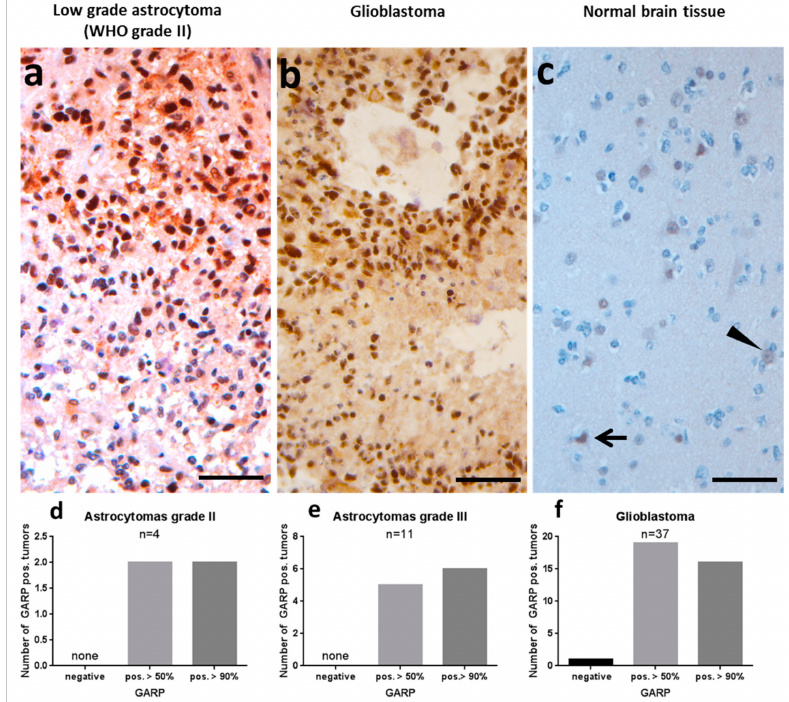
Figure 2. Glycoprotein A repetition predominant (GARP) immunohistochemistry in gliomas and astrocytomas. ( a , d , e ) Low-grade astrocytoma (WHO grade II) with more than 50% positive (pos.) labeled nuclei (magnification × 400). ( b , f ) GB with palisading necroses and more than 90% pos. stained tumor cells (magnification × 400). ( c ) Largely normal brain tissue in the neighborhood of a glioma with some labeled neurons (arrow) while others where unstained (arrowhead). Bar corresponds to 50 µ